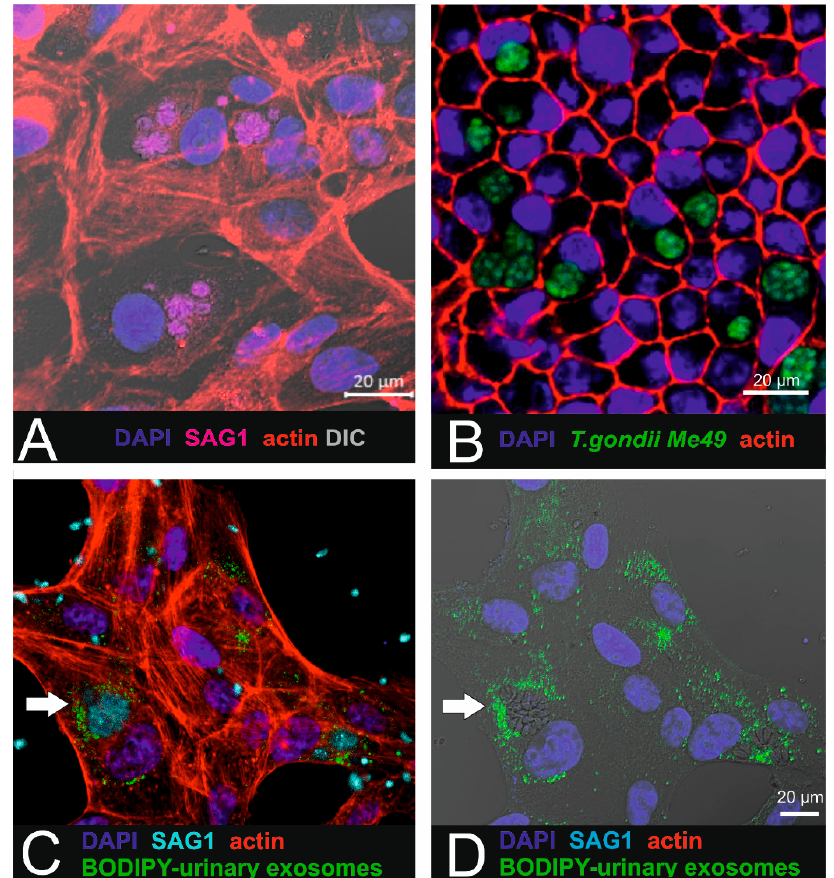
Figure 5. Combination of parasite infection with urinary exosome uptake in RPE1 cells. ( A ) T. gondii -infected ARPE-19 cells. SAG-1 immunoreactivity reveals the presence of the parasites. ( B ) In pigmented iPSC-derived RPE cells (cobblestone morphology), intracellular localized parasites ( Me49 T. gondii ) are arranged in cysts. ( C , D ) Micrographs showing the internalized BODIPY-labelled urinary small EVs (green) localized in close proximity to the parasites (cyan: SAG1 parasite surface antigen). Target cells were ARPE19